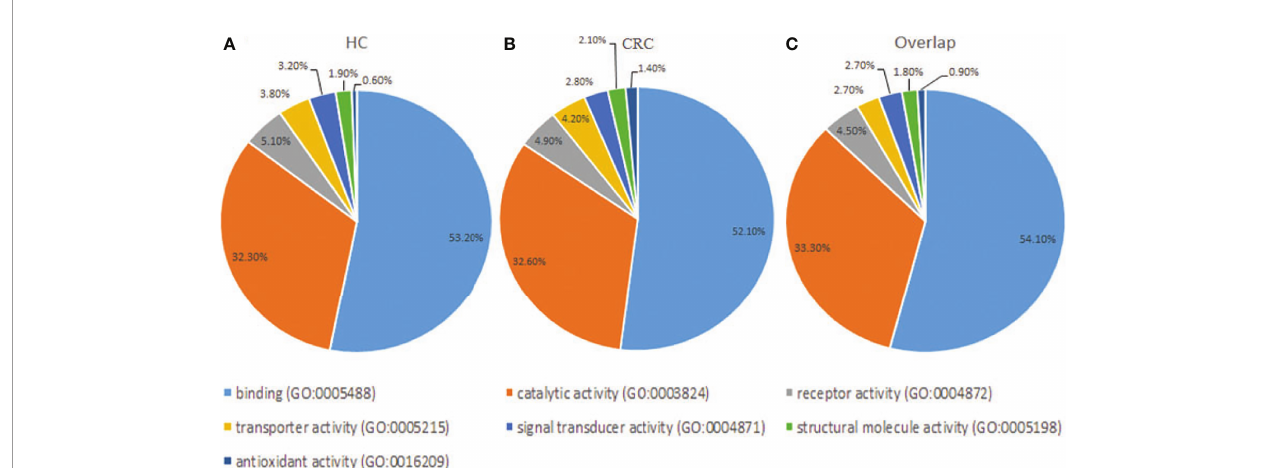
FIGURE 4 | Gene Ontology analysis of the distribution of glycoproteins according to molecular function (http://exocarta.org/exosome_markers_new). (A) Paracancerous tissue exosomes (HC). (B) Cancer tissue exosome (CC). (C) Common cancer tissue and paracancerous tissue exosomes (Overlap). The frequencies of the glycoprotein functional categories are presented as percentages.